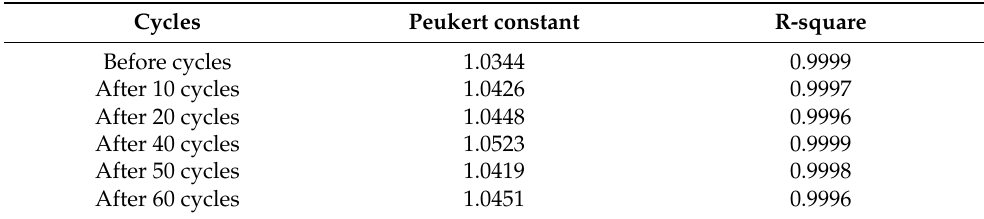
Table 1. The Peukert constant of cell no. 2 during aging cycles. Cycles Peukert constant R-square Before cycles 1.0344 0.9999 After 10 cycles 1.0426